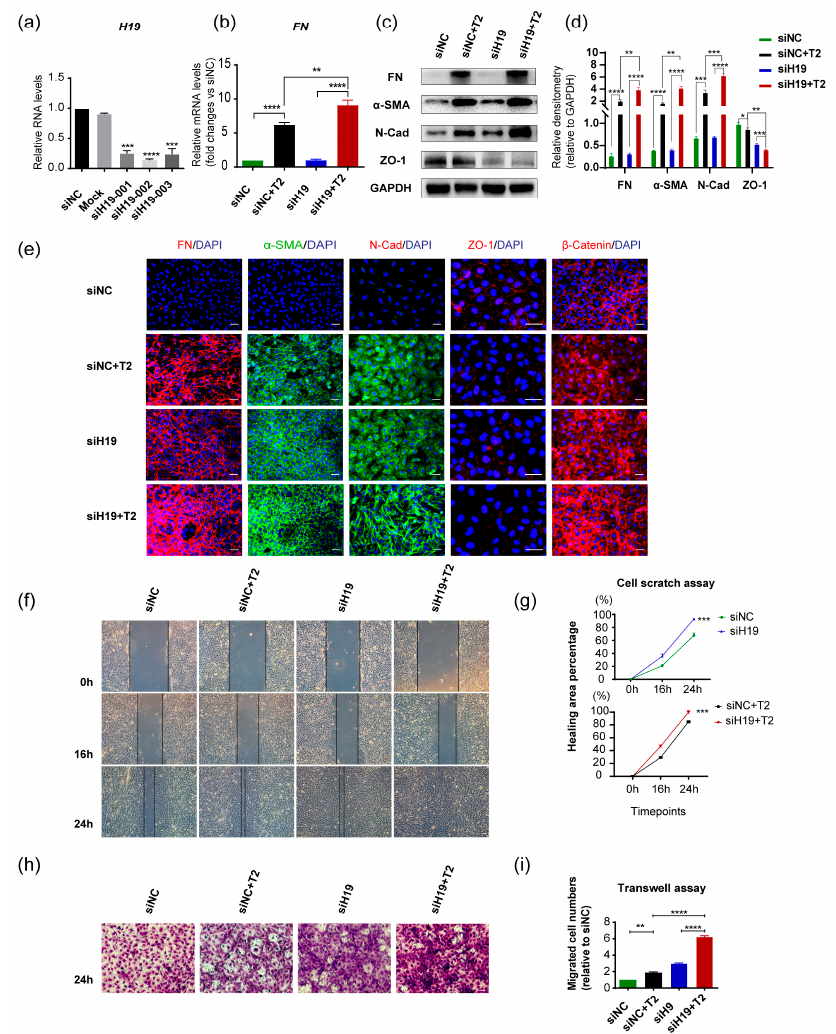
Figure 3. Downregulation of H19 in SRA01/04 cells aggravated TGF- β 2-induced EMT. ( a ) After transient transfection with H19 siRNAs in SRA01/04 cells for 48 h, H19 expression was determined by quantitative real-time PCR. ( b ) FN mRNA levels were detected in SRA01/04 cells after transfection with si H19 -002 for 24 h and further exposure to TGF- β 2 for 24 h. ( c , d ) Protein levels of mesenchymal markers FN, α -SMA, N-Cad, and epithelial markers ZO-1. Representative western blots and densitometric analyses (mean ± SD) are shown (n= 3 per group). Protein data are expressed as a ratio to GAPDH. ( e ) Staining of FN, α -SMA, N-Cad, ZO-1, and β -catenin in SRA01/04 cells. Scale bars, 50 μ m. ( f – i ) After transfection with si H19 -002, the migration capacities of SRA01/04 cells induced by TGF- β 2 was detected by cell scratch assay ( f , g ) horizontally and Transwell assay ( h , i ) vertically. Image J was used for further quantification and calculation. Scale bars, 50 μ m. * p < 0.05, ** p < 0.01, *** p < 0.001, **** p < 0.0001 vs. control group(siNC).